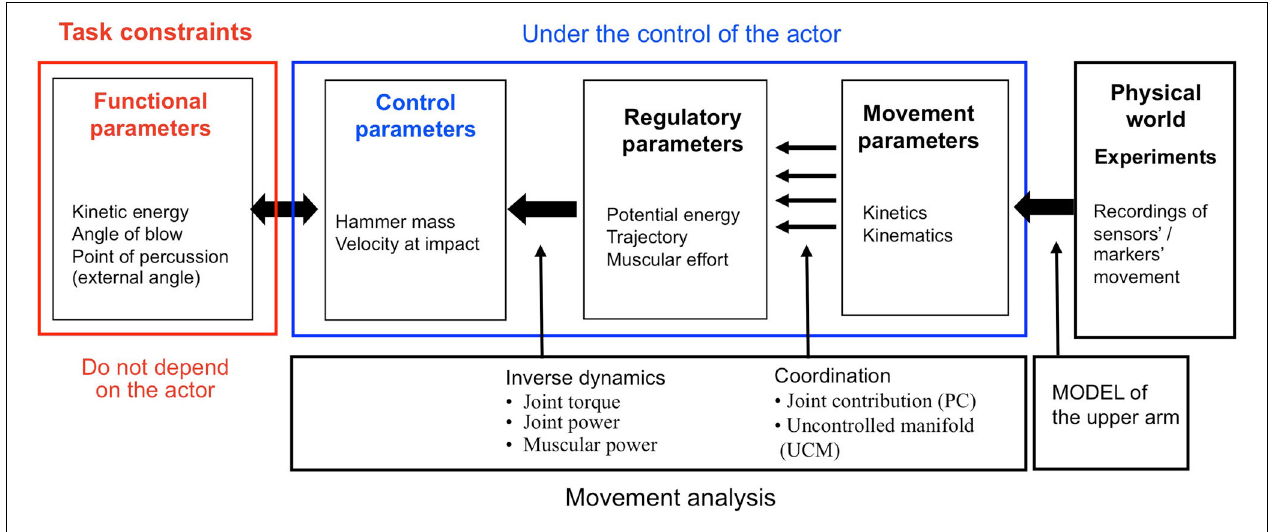
FIGURE 2 | Framework for the study of percussive tool use actions. Successful task performance is dependent upon satisfying task constraints. The experiment presented here used a series of sensors to record upper limb